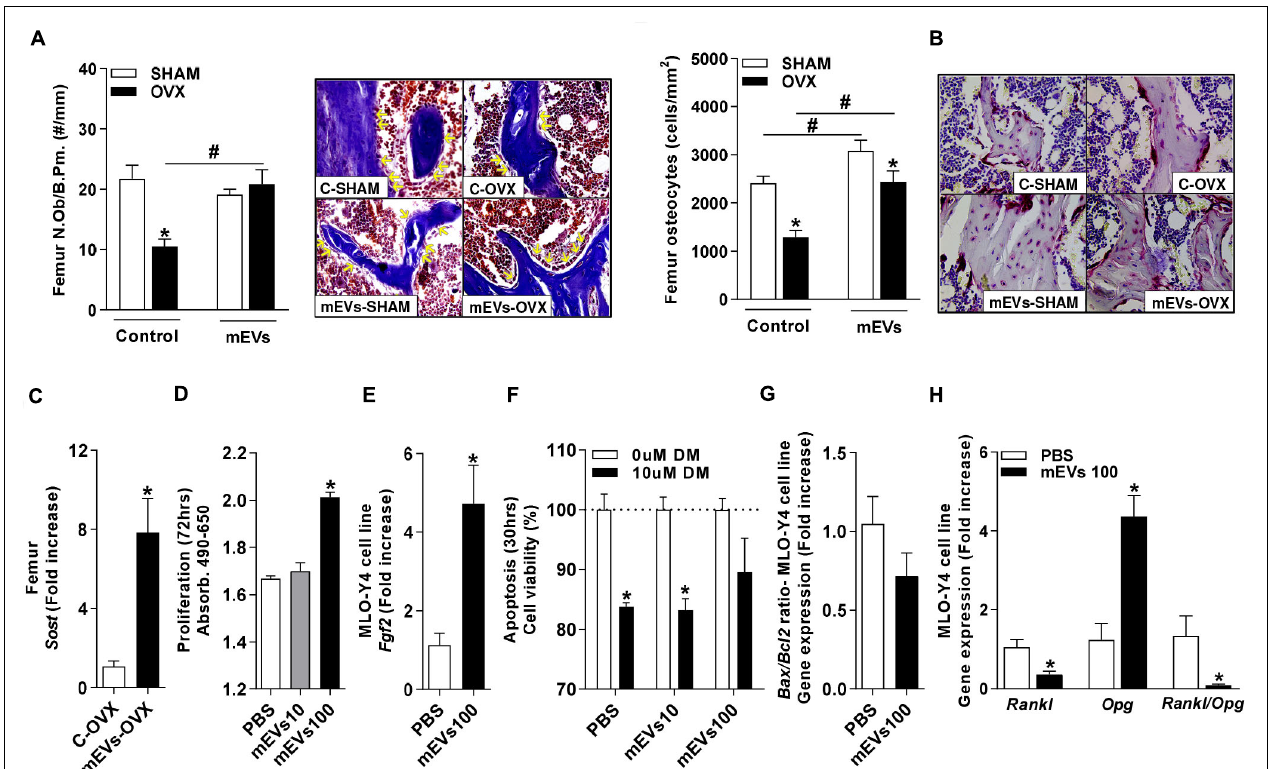
FIGURE 6 | Effect of milk extracellular vesicle treatment in the osteocytes. (A) Number of osteoblasts (N.Ob) per bone perimeter (B.Pm) and representative pictures of osteoblasts in the trabecular bone (400 × ). Yellow arrows indicate osteoblasts. (B) Osteocyte density and representative pictures of osteocytes in the trabecular bone (400 × ). (C) mRNA expression of sclerostin in the femur. Analyses were performed in mice (i) pseudo-operated (SHAM) or (ii) ovariectomized (OVX), (iii) non-treated (control), or (iv) treated with milk extracellular vesicles (mEVs). Values are means ± SEM of 6–8 animals per group. * vs. respective SHAM group and # vs. non-treated group. P < 0.05. Osteocyte MLO-Y4 cell line (D) proliferation assay and (E) Fgf2 mRNA expression. (F) Apoptosis assay of osteocyte cell line treated with dexamethasone (DM) (10 µ M) and mEVs (10 and 100 µ g/ml). mRNA expression of (G) Bax / Bcl2 ratio and (H) Rankl , Opg , and Rankl / Opg ratio in osteocyte culture treated with mEVs (100 µ g/ml) ( n = 4). Bars represent the mean ± SEM. * vs. PBS. P < 0.05.